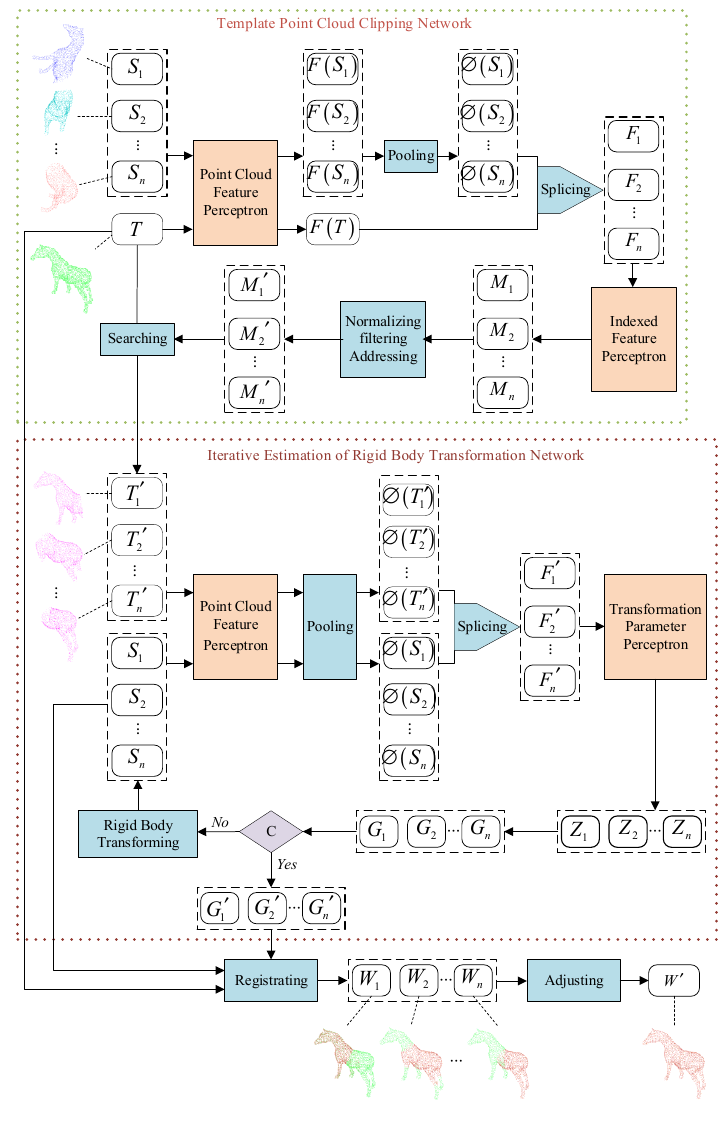
Figure 1. The network architecture of the MPCR-Net.